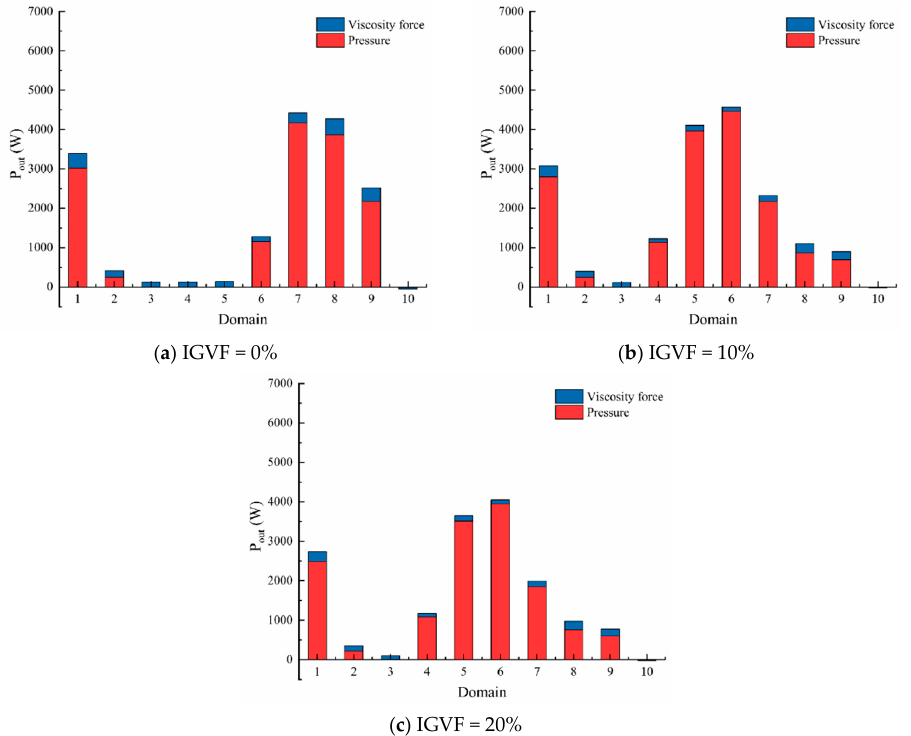
Figure 12. The distribution of the output power within each fluid domain under different IGVFs at the fracture cavitation stage. the fracture cavitation